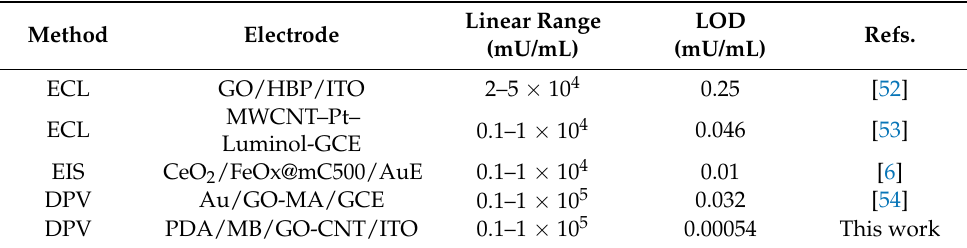
Figure 8. ( a ) DPV response of the immunosensor to different concentrations of CA19-9, from 0.1 mU/mL to 100 U/mL. ( b ) Calibration curve of the proposed electrochemical immunosensor. Error bars represent the standard deviations of three measurements. Table 1. Comparison of detection performance of our sensor with some other reported methods for the determination of